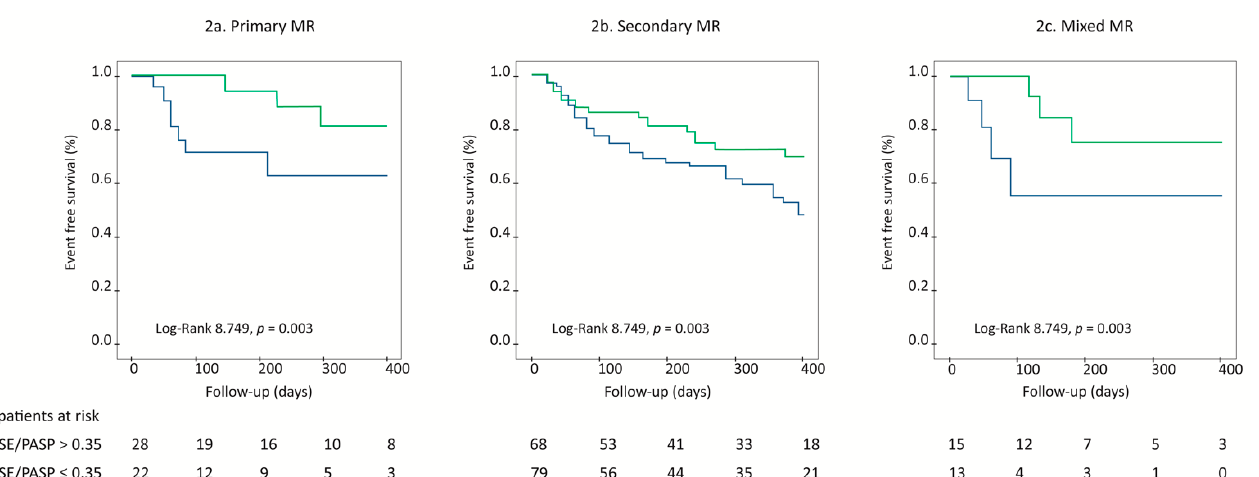
FC: functional class. NYHA: New-York heart association. LVEF: left ventricular ejection fraction. PASP: pulmonary artery systolic pressure. TAPSE: tricuspid annular plane excursion. TR: tricuspid regurgitation. SE: standard error. STS-Score: Society of Thoracic Surgery Score.